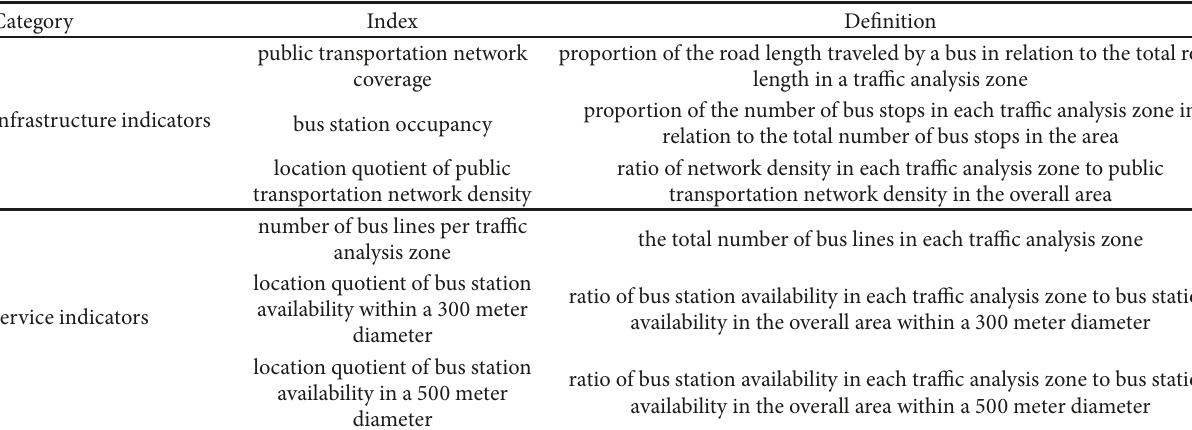
Table 1: Evaluation index system of spatial deprivation of public